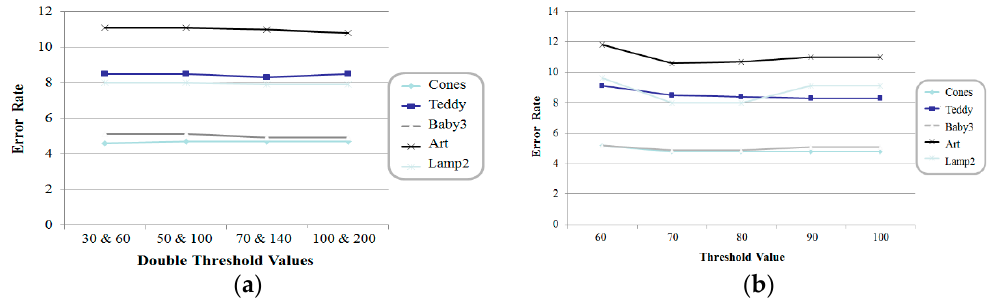
Figure 8. Comparison of error rates with respect to the threshold values of ( a ) Canny detector and ( b ) DoG method.